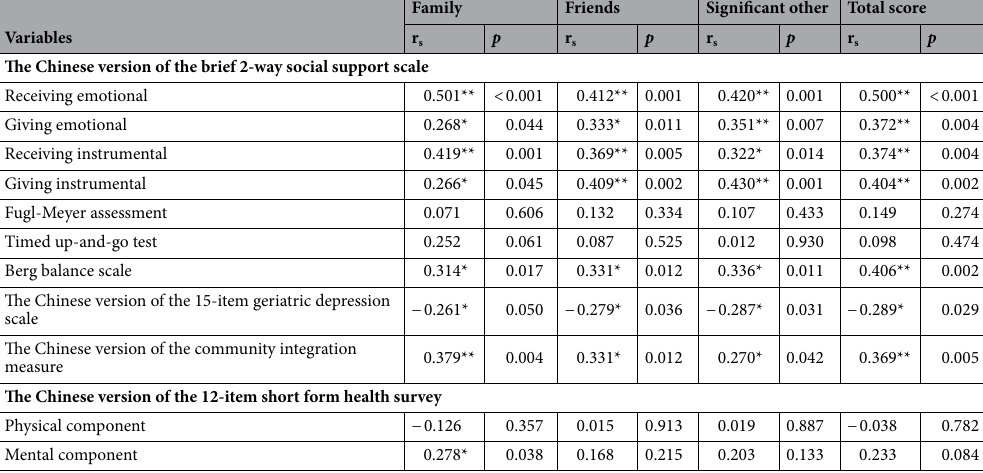
Table 3. Correlations between MSPSS-C and other outcome measures. p < 0.05*, p <